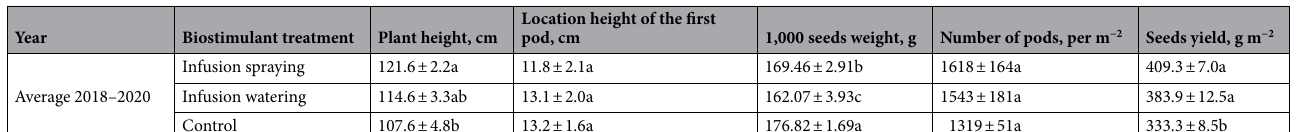
Table 4. Response of soybean plants to biostimulating allelopathic extracts—soybean yield and its elements (mean values of 2018–2020 ± SD). Means in the columns, concerning the selected traits, followed by different letters are significantly different at p < 0.05.